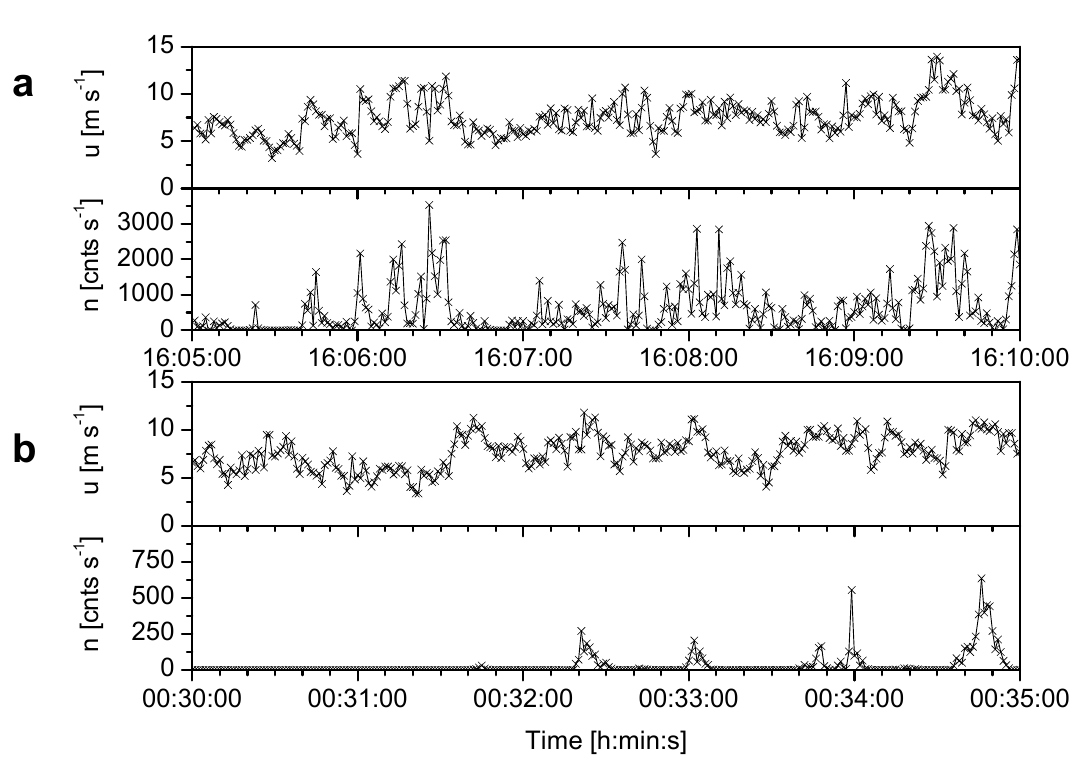
Figure 1. Time series of instantaneous horizontal wind velocity u and blown-sand impact count n at the Hasaki Beach [22,31]; the data were recorded for 5 min at a frequency of 1 Hz (a) during intervals without rainfall on 12 January 2005 and (b) after a rainfall event on 25 September 2005. The wind velocity was measured using an ultrasonic = 0.9 m). The impact anemometer at a height of 0.9 m above the flat ground surface ( z u count was measured using UD-101 at z = 0.04 m. The horizontal distance between the s of the ground surface wind and saltation sensors was 1 m. The median sand grain size d 50 at the beach was 0.2 × 10 –3